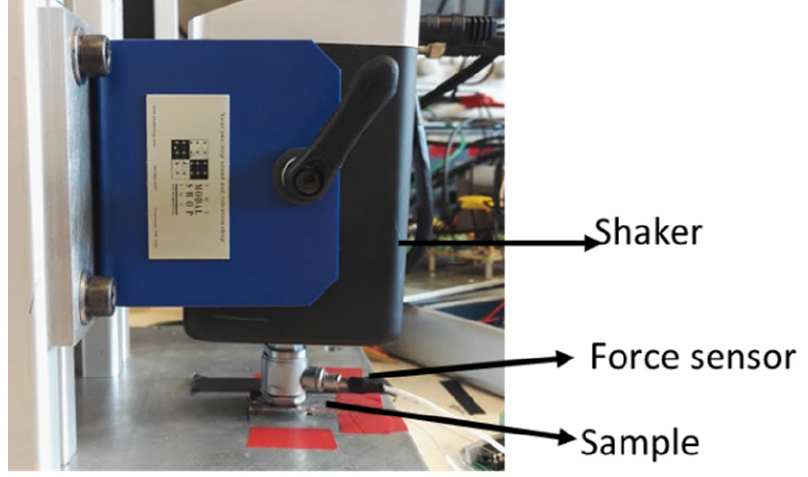
Figure 7. Experimental setup for the NG test in compression mode.